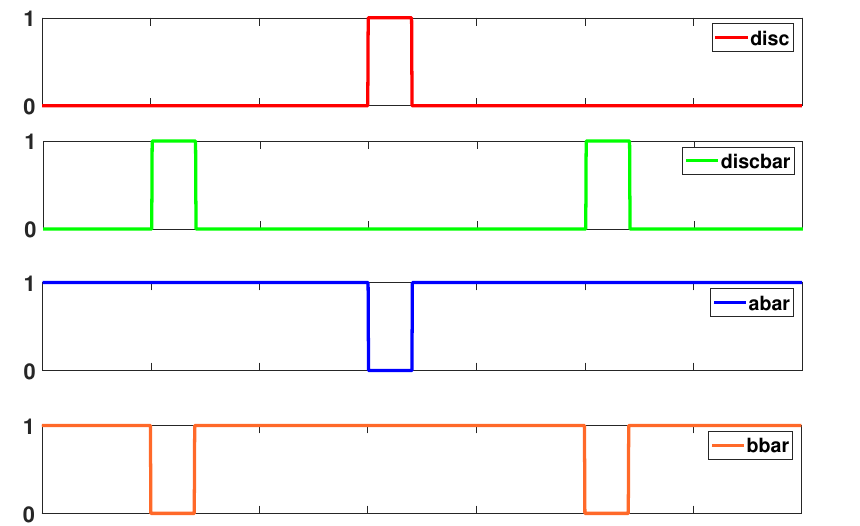
Figure 8. Signals used to control operation of Power Clock Generator